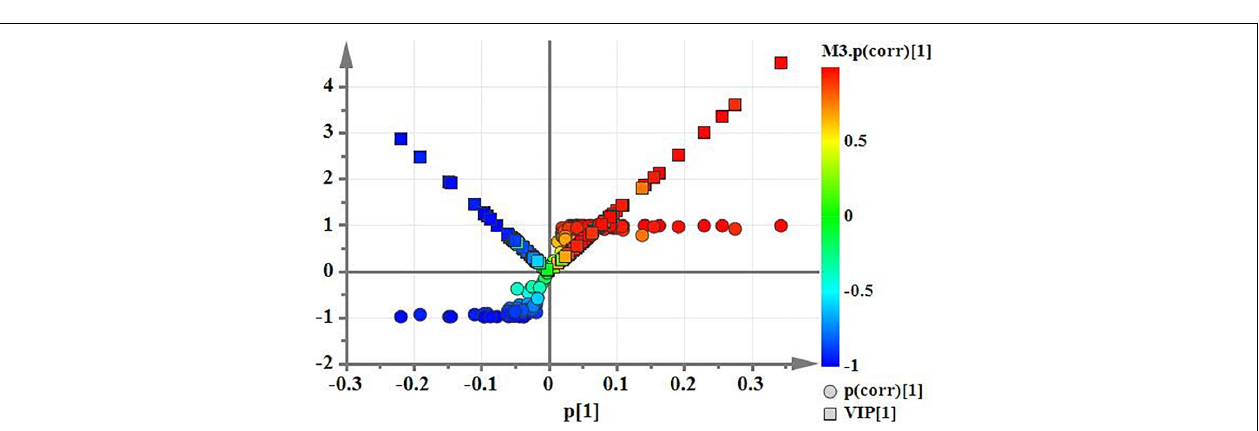
FIGURE 8 | (V+S) plot of OPLS-DA model analysis selecting the differential metabolites of the individually cultured MTB in the absence and presence of 8.0 µ g/ml DHA-CS